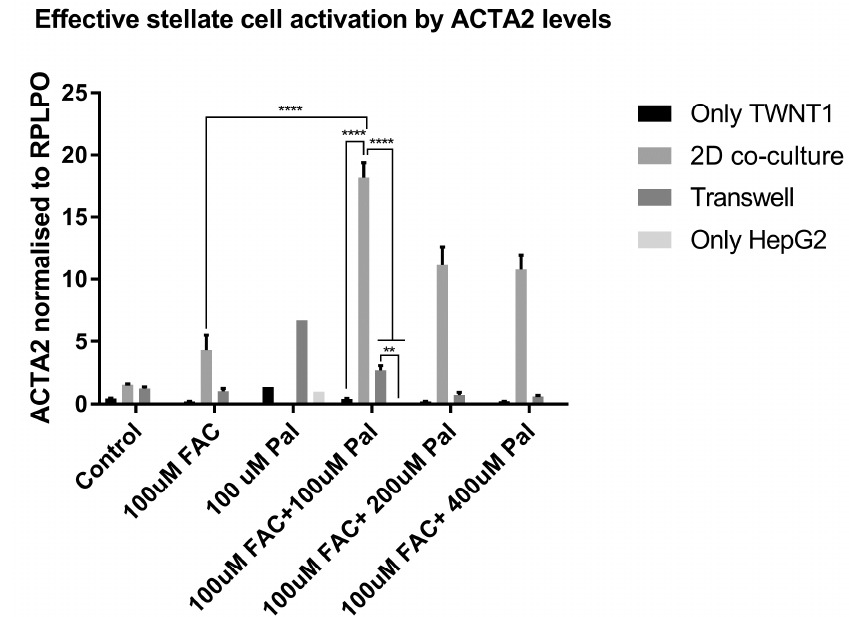
Figure 6. Hepatocyte-stellate cell interaction is necessary for iron- and fat-induced fibrogenesis: mRNA expression of smooth muscle actin (ACTA2), upon treatment with iron (FAC) and palmitate (Pal). n = 3 biological replicates. Error bars are shown as means ± SE. p values were calculated by two- way ANOVA with post hoc Tukey’s multiple comparisons test. ** 0.001 ≤ p ≤ 0.01; **** p <